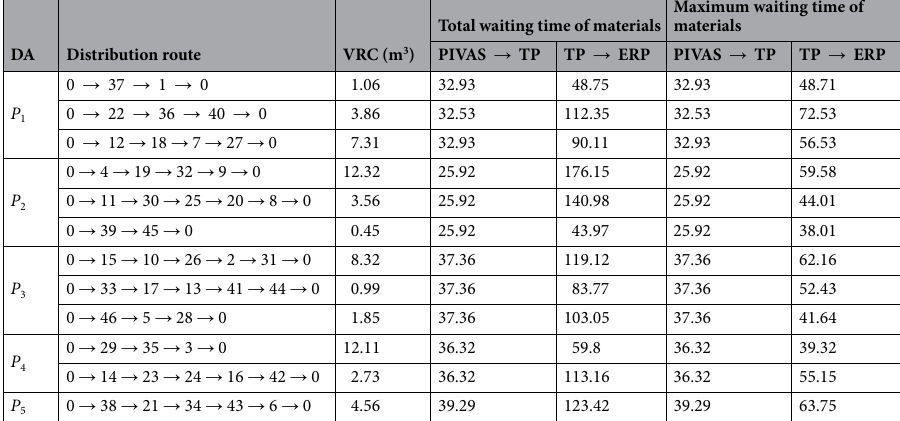
DA Distribution